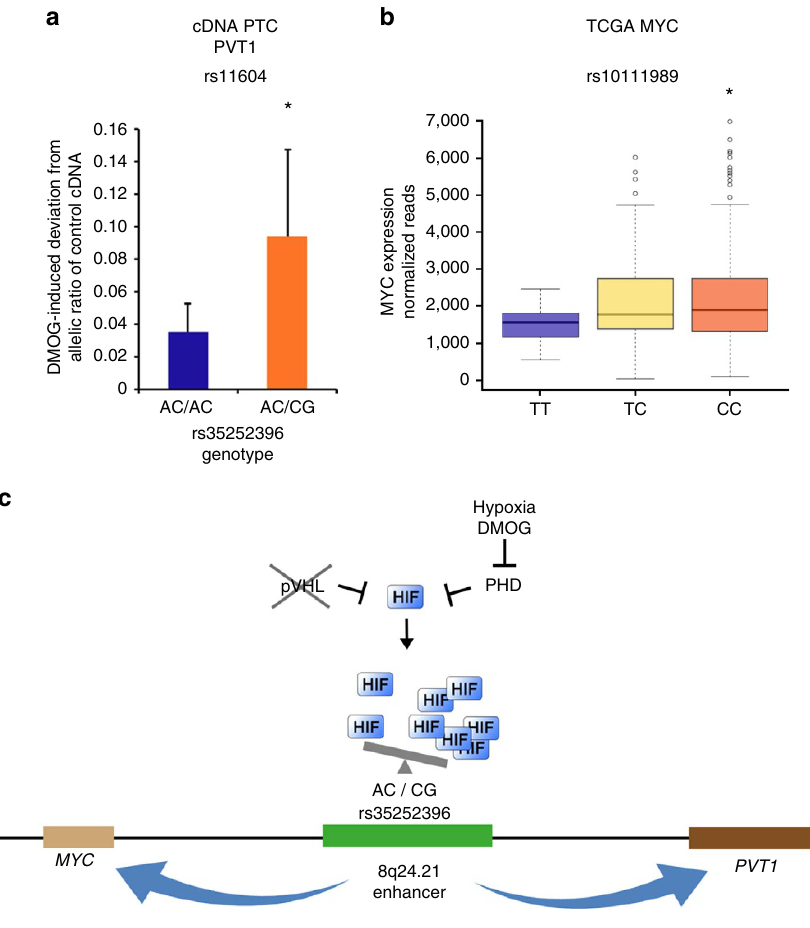
Figure 5 | Polymorphisms at 8q24.21 influence expression of MYC and PVT1. ( a ) HIF stabilization leads to allelic imbalance in PVT1 expression. Twelve primary renal tubular cell cultures (PTC) were identified that are heterozygous for SNP rs11604 that resides in the coding region of PVT1 . Four individuals had an AC/AC genotype and eight individuals had an AC/CG genotype at rs35252396. For rs11604, the ratio of allele-specific signals was measured by qPCR (FAM/VIC) from input genomic DNA and cDNA derived from control (untreated) or DMOG-treated cells. No significant allelic imbalance at rs11604 was detected between the two groups (AC/AC or AC/CG at rs35252396) in input genomic DNA or cDNA from untreated cells (Supplementary Fig. 14). We then calculated the change of allelic ratios of cDNA from DMOG-treated cells compared with the respective control untreated cDNA. We detected a significant greater change in allelic PVT1 expression induced by DMOG in cells from individuals with an AC/CG genotype at rs35252396. Values are mean ± s.d. from four (AC/AC) or eight (AC/CG) individuals. qPCRs for DNA and cDNA were performed in triplicates per individual. *Student’s t